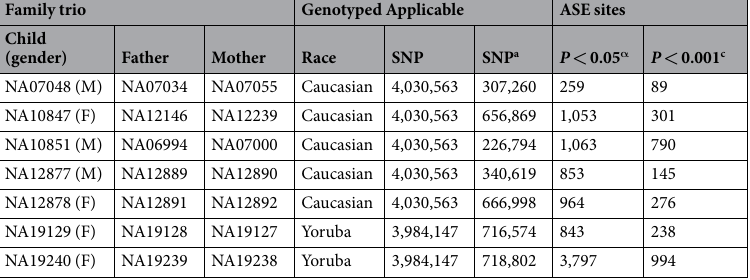
Table 1. The applicable SNP sites and identified ASE events for each trio. a The heterozygous SNPs that were informative for analysis in the child of a trio family (see Materials and Methods). b The heterozygous SNPs exhibited imbalanced expression between two alleles ( P value < 0.05 by the Chi -square test). c The heterozygous SNPs exhibited imbalanced expression between two alleles, with the ratio of the read count of the higher expressed allele to that of the other allele over two and ASE score > 3 ( P value < 0.001 by the Chi -square